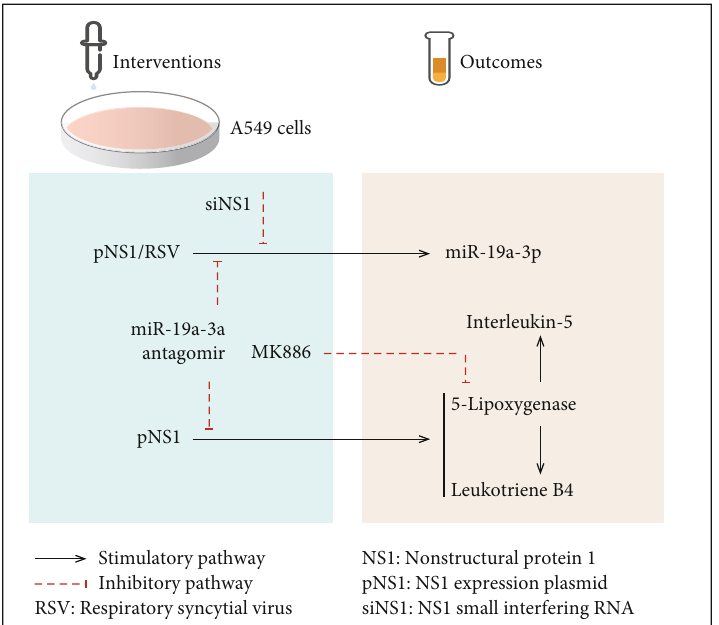
Figure 5: Summary of fi ndings. RSV and pNS1 promote the expression of miR-19a-3p in A549 cells. NS1 small interfering RNA alleviates the e ff ect. pNS1 increases the levels of 5-lipoxygenase, interleukin-5, and leukotriene B4, which could be attenuated by inhibitors of miR-19a-3p or 5-lipoxygenase. Black arrows: activation; dotted red lines: inhibition. RSV: respiratory syncytial virus; NS1: nonstructural protein 1; pNS1: NS1 expression plasmid; siNS1: NS1 small interfering